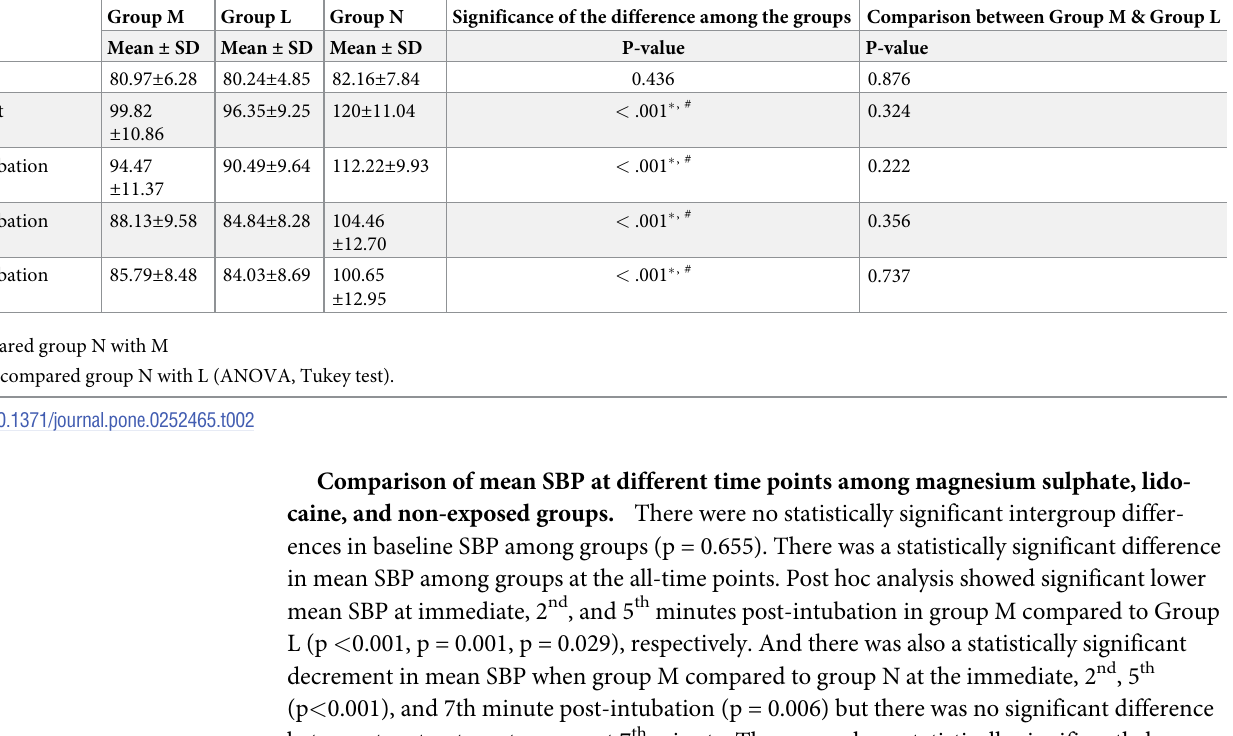
Table 2. Comparison of mean heart rate among the groups and between groups in Zewditu Memorial Hospital, Addis Ababa, 2018/2019. Time interval Group M Group N Significance of the difference among the groups Comparison between Group M & Group L